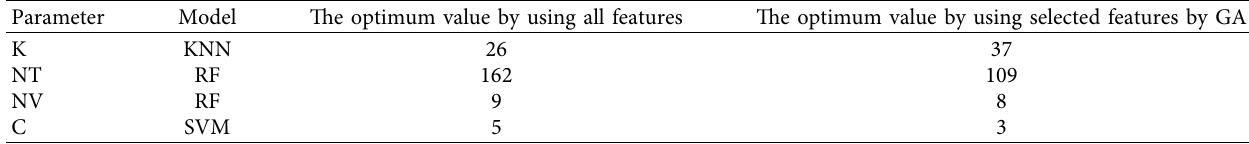
Figure 4: Proposed ensemble learning Table 4: Optimum values for parameters of models.